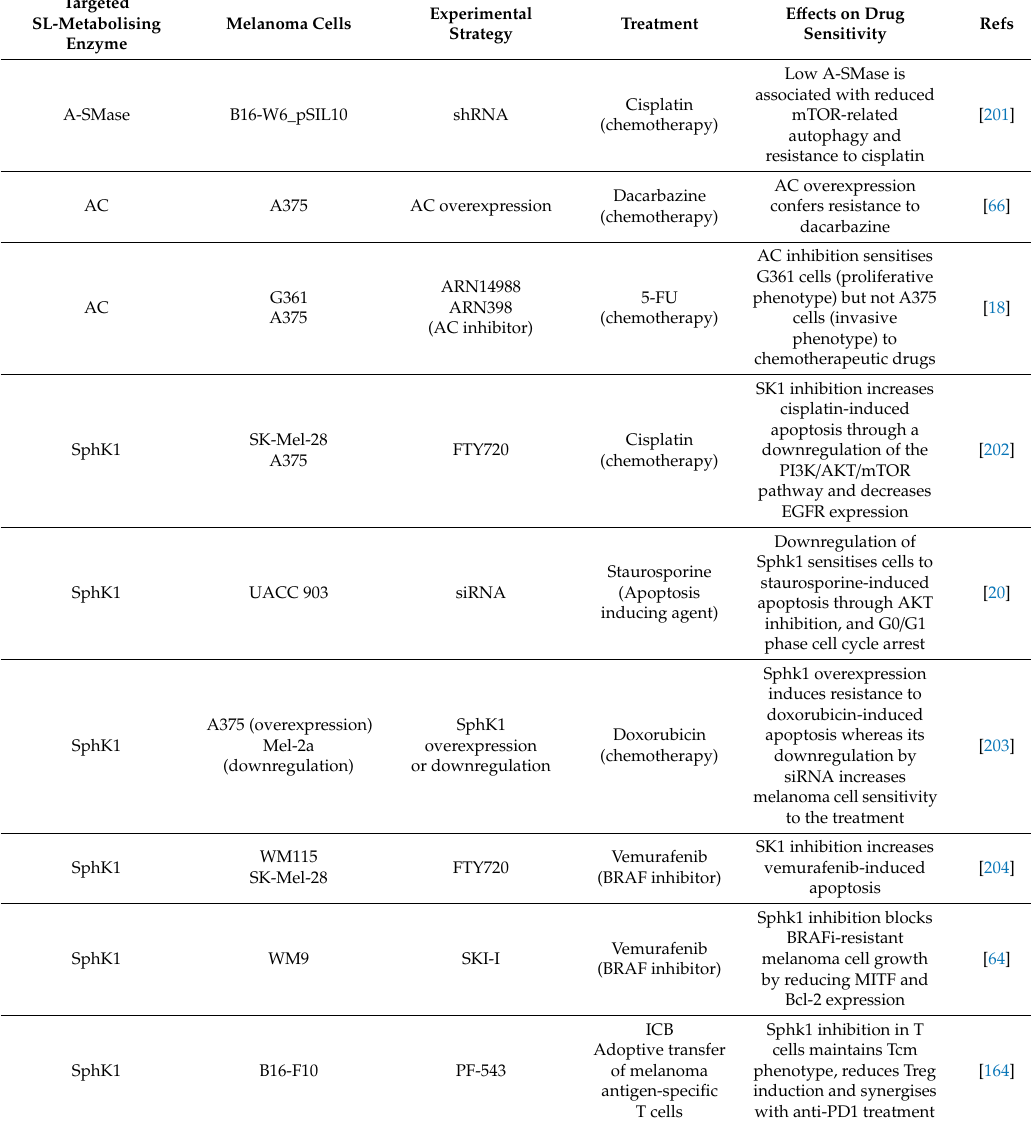
Table 2. SL-metabolising enzymes regulate the response of melanoma to